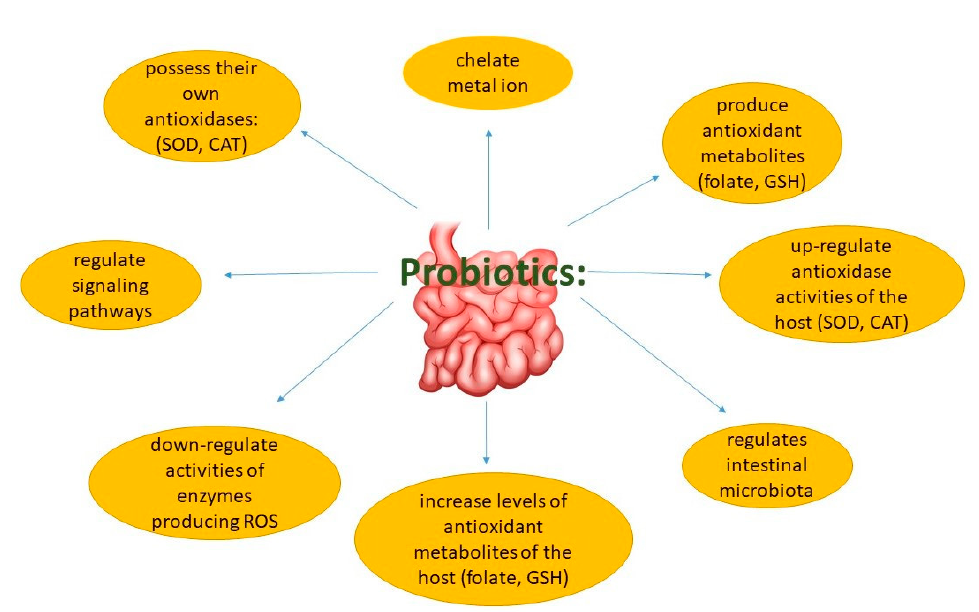
Figure 2. Modulation of antioxidation by probiotics.